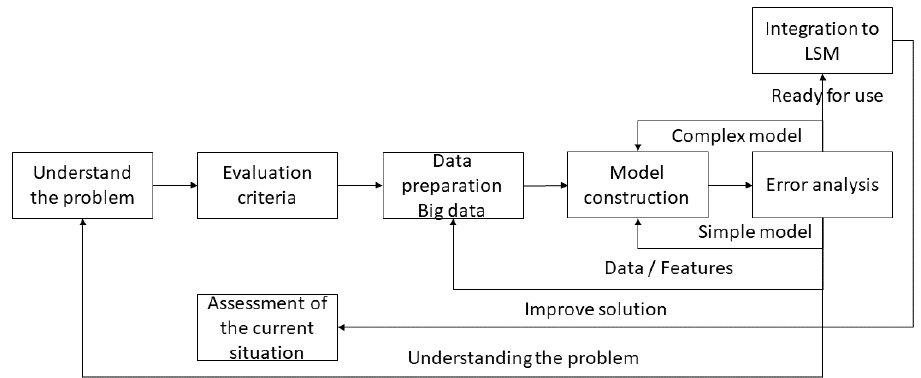
Figure 3. Phases for the implementation of a machine learning model.